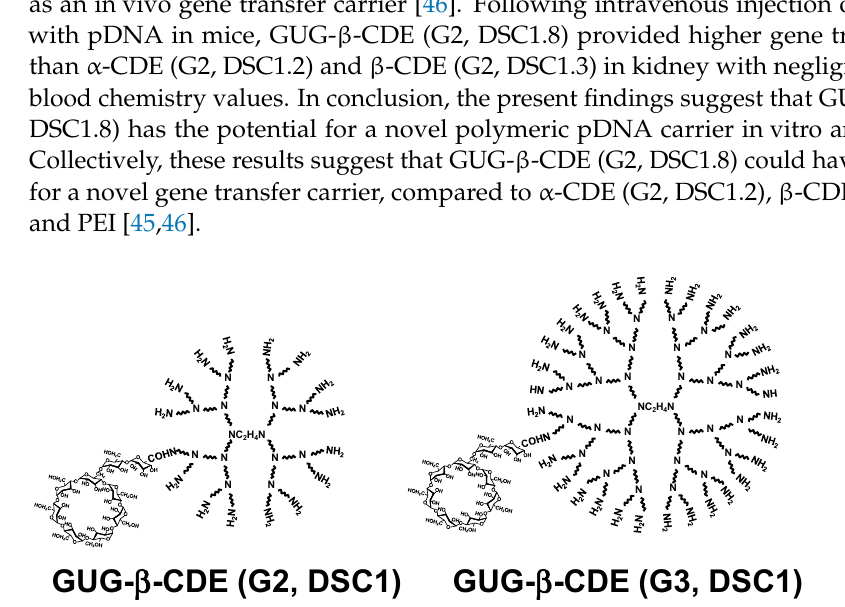
Figure 5. Chemical structure of GUG- β -CDEs .